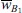
Fitness and distribution of gamete types.Parameters: n = 20, μ = 10−4, c
h = 0.2 and concave fitness. U
1 gametes appear at generation 0, which is the point at which the B
1 and B
2 gametes reach mutation-selection equilibrium. (A) Relative advantage of each gamete through time (see Model for details). For B-F, the relative proportion is the sum of a particular gamete type (e.g. a homoplasmic wild type U
1 gamete) divided by the sum of all cells carrying that allele (all gametes carrying the U
1 allele). Thus, the relative proportion describes how an allele is distributed across different gamete types but it does not show their actual frequencies in the population. The heteroplasmic category combines all gametes with any level of heteroplasmy. B-D show the distribution of gametes carrying the U
1 allele (B), B
1 allele (C) and the B
2 allele (D). E-F show a more detailed distribution of gametes carrying the B
1 allele at generation 1350 (E) and generation 1820 (F). The decrease in heteroplasmy in B
1 and B
2 gametes between generations 0–100 is an artifact of introducing U
1 at a frequency of 0.01 (the influx of U
1 gametes homoplasmic for the wild type haplotype converts some heteroplasmic B
1 and B
2 gametes into homoplasmic gametes). From generations 1350–1820, the proportion of heteroplasmic B
1 and B
2 gametes decreases (C and D) but the level of heteroplasmy increases (compare E with F). This more than offsets the decrease in the proportion of heteroplasmic cells and w¯B1 continues to decrease (A). Around generation 1350, B
2 gametes homoplasmic for mutant mitochondria begin to appear, which causes w¯B2 to increase and eventually converge with w¯U1.